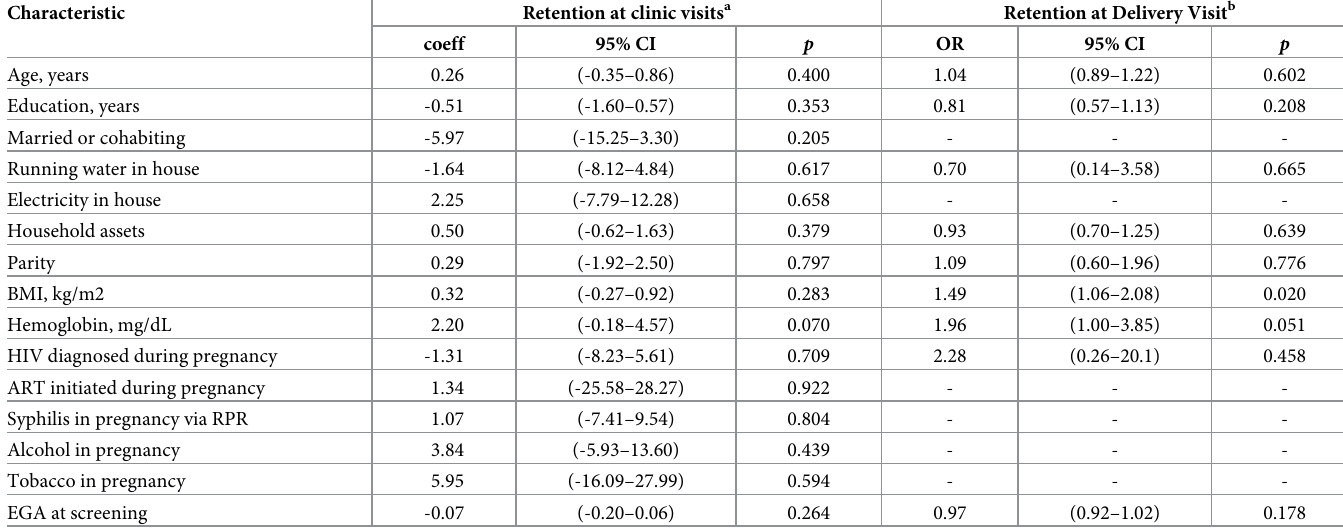
Table 5. Baseline correlates of participant retention at clinic visits and at the delivery visit.